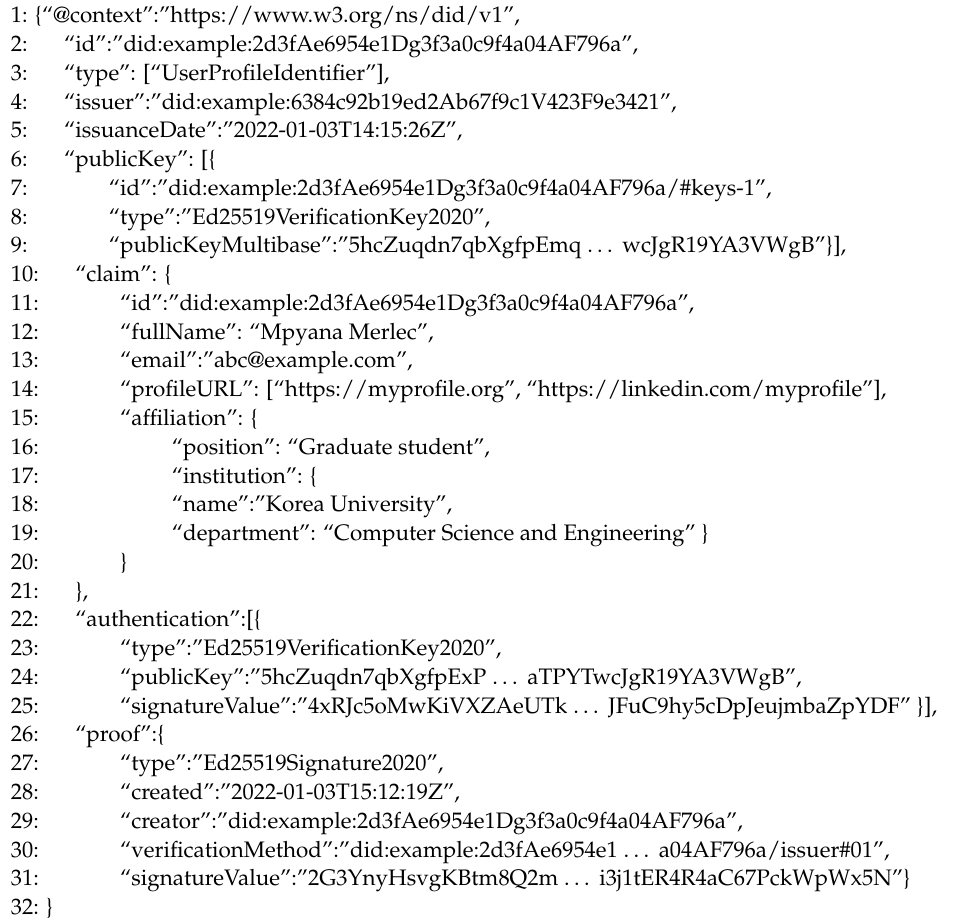
Figure 2. Example of a DID format.